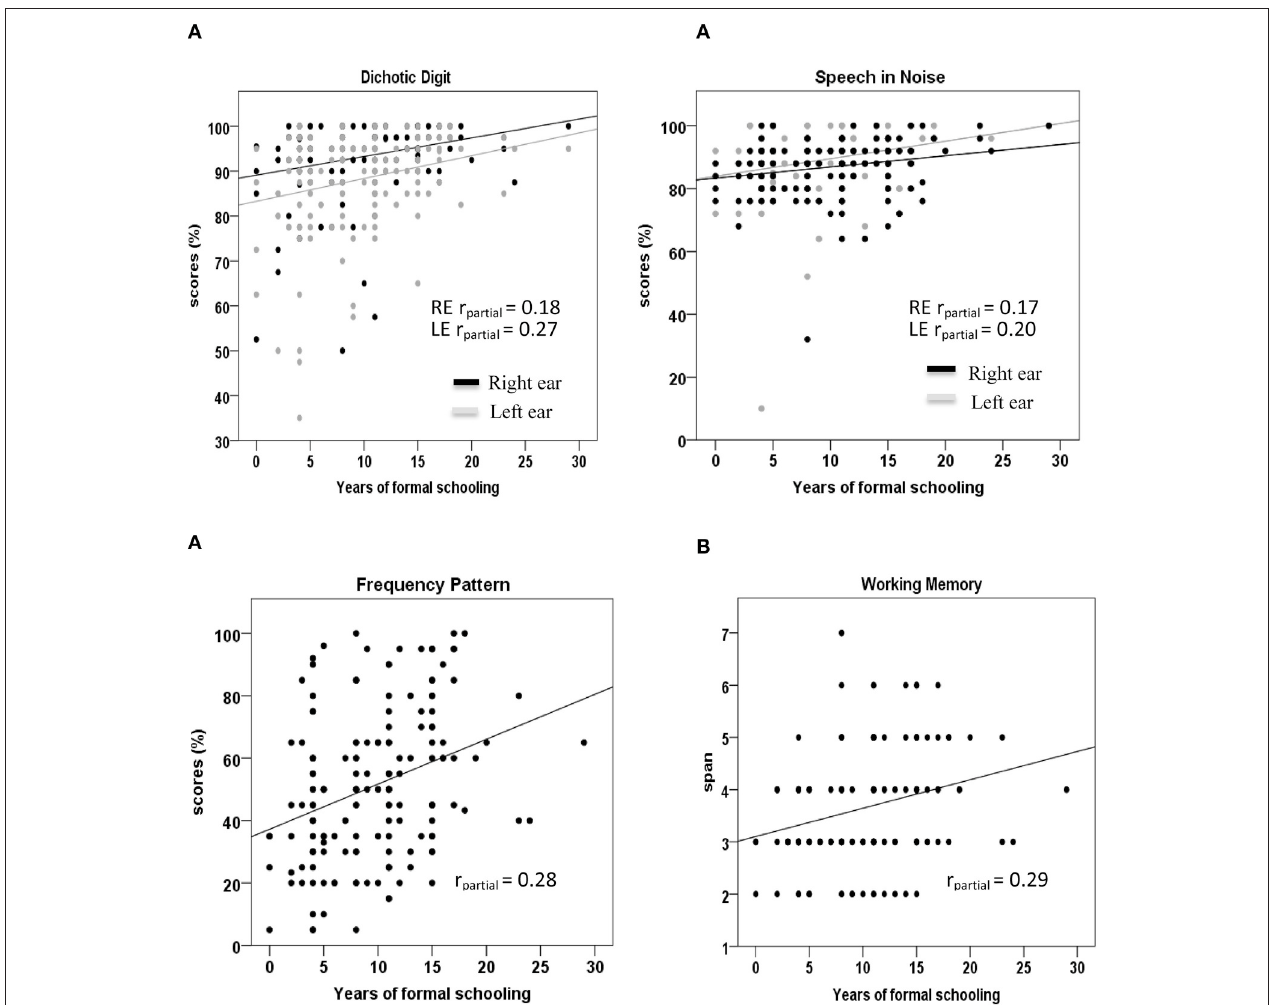
FIGURE 1 | Scatter plots of years of schooling vs. (A) auditory processing tests and (B) working memory test. Significant ( p < 0.05 ) correlation coefficients (r) for all participants with age, income, and hearing partialled out, are demonstrated in each